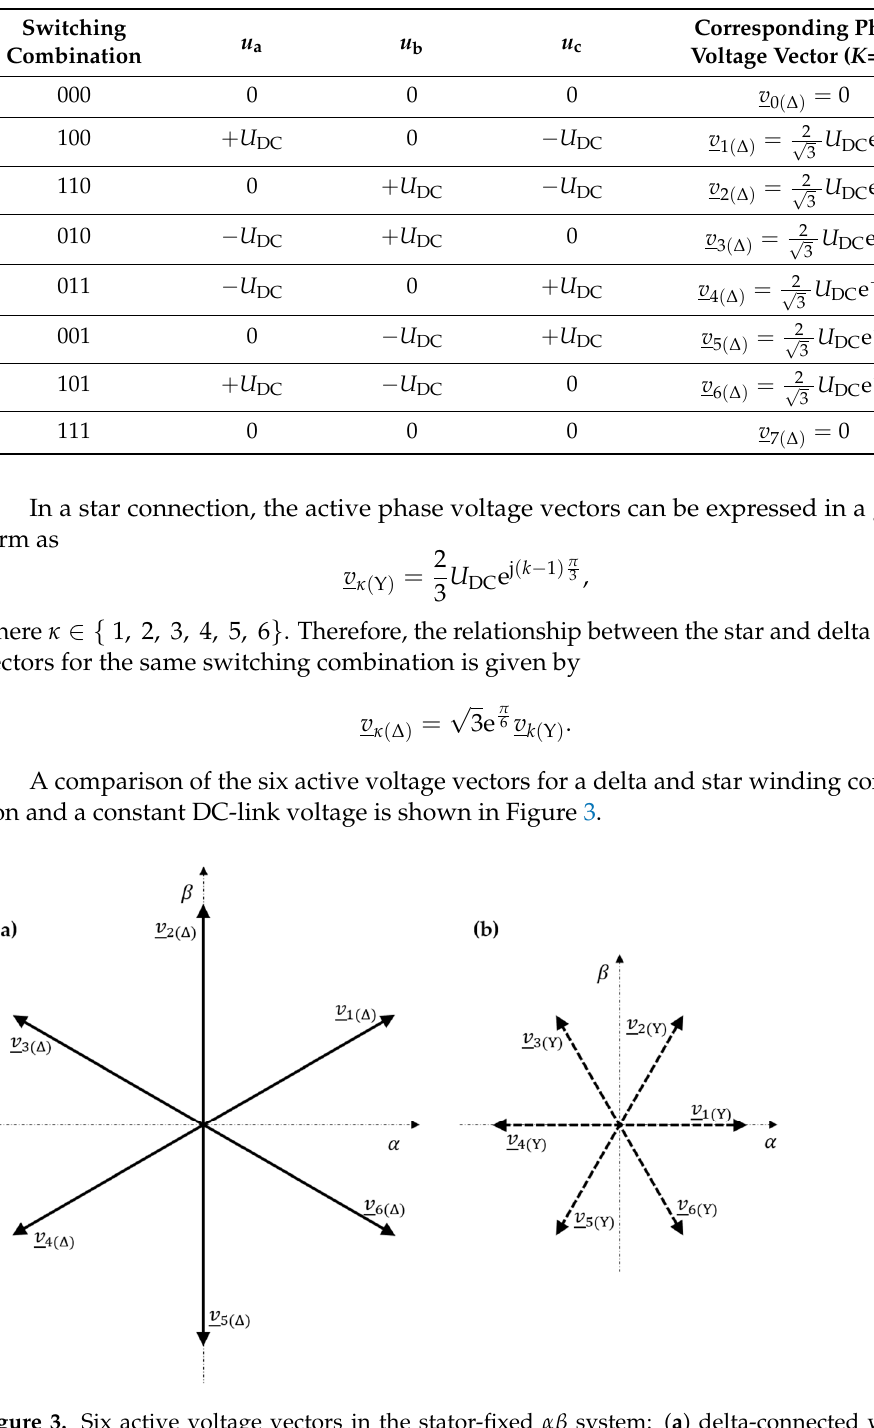
Table 1. Switching combinations and corresponding voltage vectors for delta-connected machine.